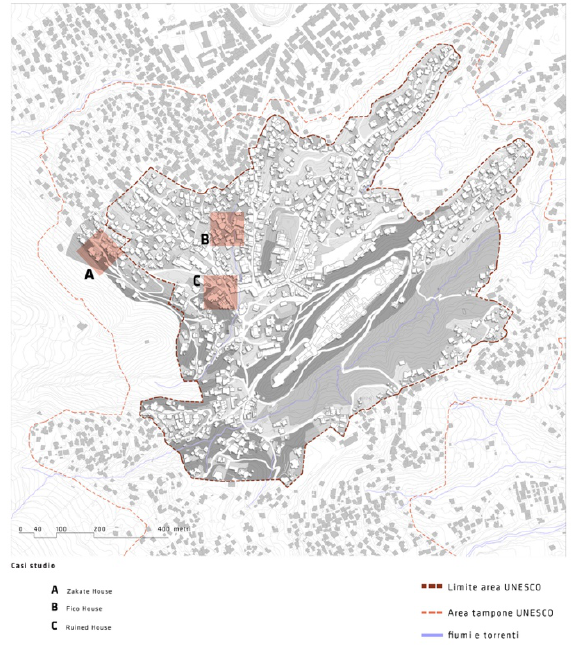
Figure 1. Plan of Gjirokastra and selected case studies (© L. Giannone, E.